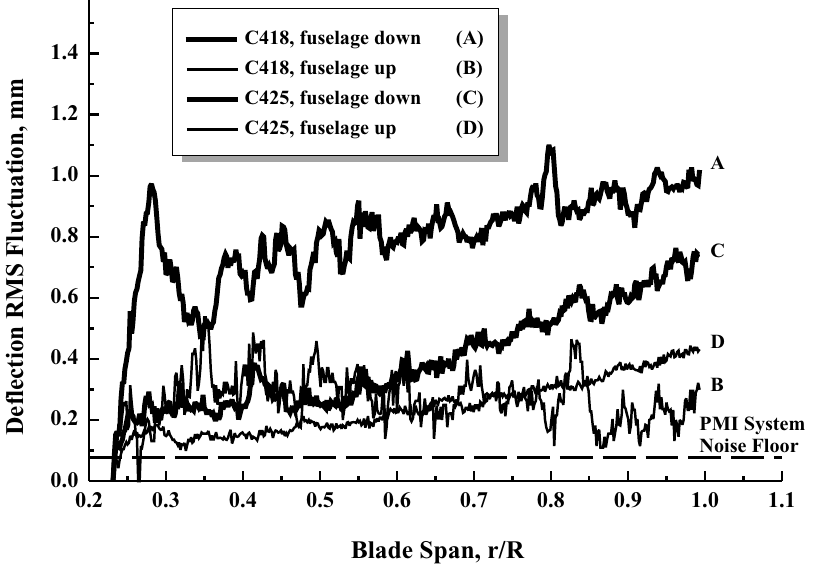
Fig. 13. Fuselage effects on blade dynamic deflection for blade #4, 25% chord, Ψ = 90 ◦ .